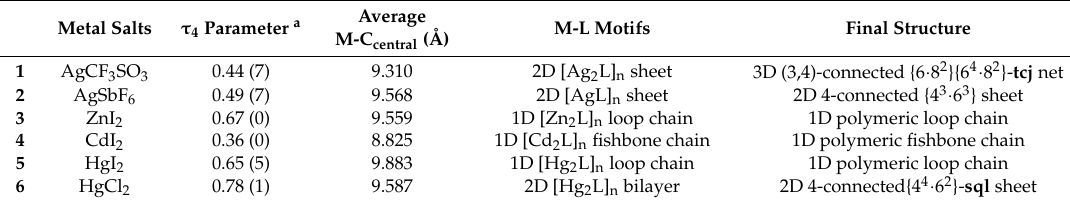
Table 1. Detailed comparisons of complexes 1 – 6 . Table 1 . Detailed comparisons of complexes 1 – 6 .